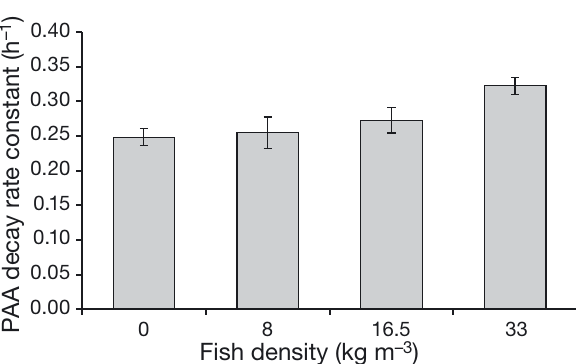
Fig. 4. Calculated decay rate constants of PAA (mean ± SD) when added to 300 l tanks (n = 20) with full-strength seawater and different biomasses (fish densities). Each bar represents a calculated PAA decay rate constant from an individual tank trial. The nominal con centration of PAA was 1.0 mg l −1 , water temperature was